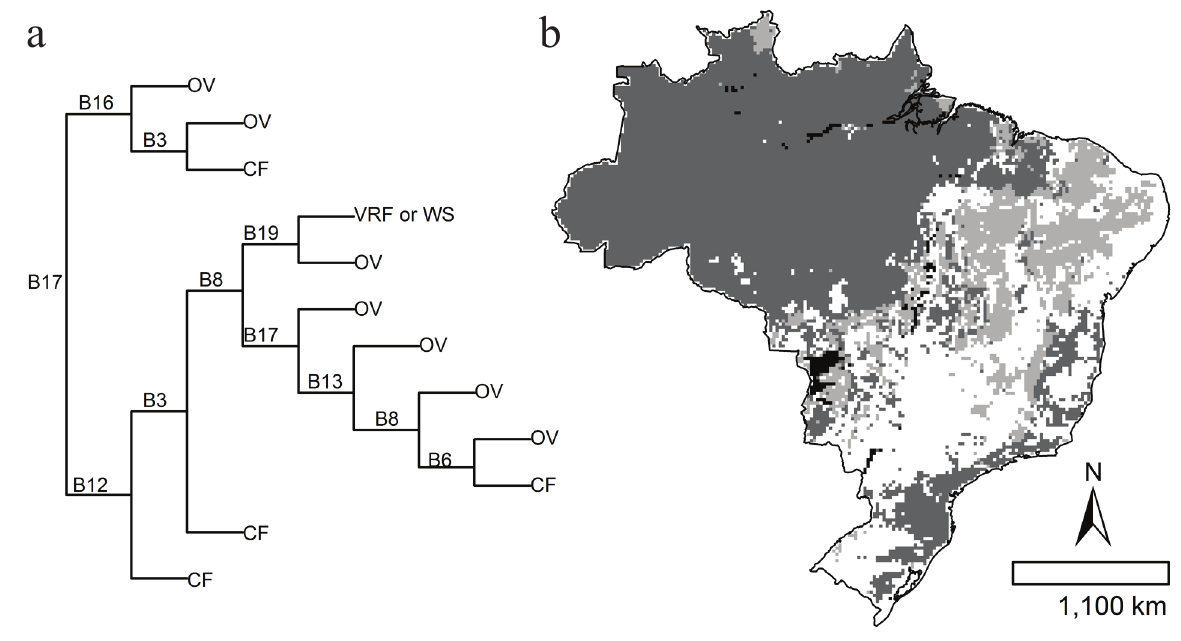
Figure 3 - Current classification of Brazilian landcover. (a) Decision tree analysis, highlighting the variables used to generate the results (B3 - Isothermality, B6 – Min. temperature of coldest month, B8 - Mean temperature of wettest quarter, B12 - Annual precipitation, B13 - Precipitation of wettest month, B16 - Precipitation of wettest quarter , B17 - Precipitation of driest quarter, and B19 - Precipitation of coldest quarter) and the native landcover predicted to final nodes (OV – Open vegetation, CF – Closed forest, and VRF or WS - closed to open vegetation on regularly flooded or waterlogged soil). (b) The reclassified Brazilian landcover according to climatic similarity, where light gray is closed to open shrubland , dark-gray is closed to open broadleaved evergreen and/or semi-deciduous forest , and black is closed to open vegetation on regularly flooded or waterlogged soil , white areas are locations under anthropogenic use and were not evaluated